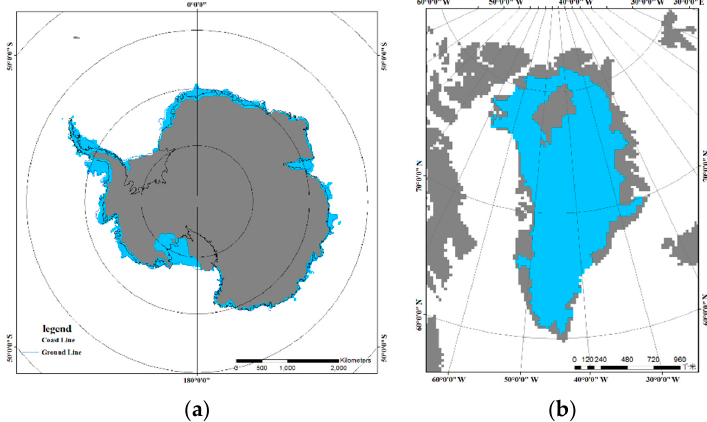
Figure 3. Average annual melt extent from 1978 to 2014 in ( a ) Antarctican and (b) Greenland ice sheets.